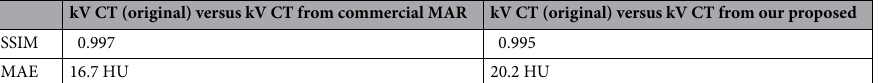
kV CT (original) versus kV CT from commercial MAR kV CT (original) versus kV CT from our